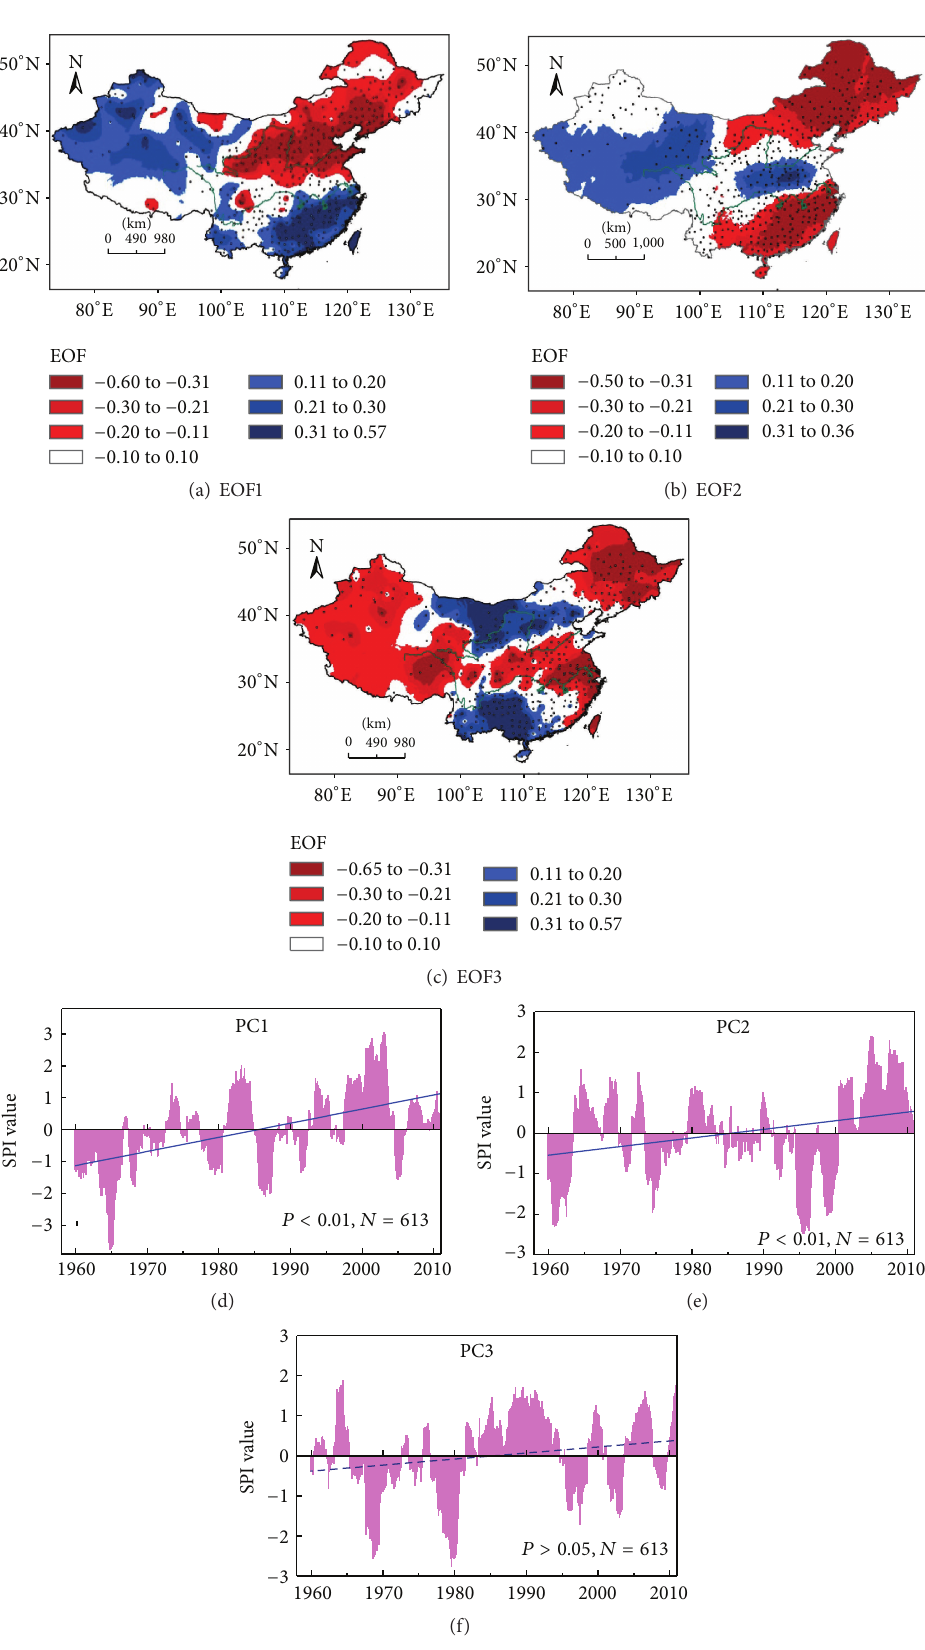
Figure 2: The first three EOF and PC of SPI-24 in China during the period of 1958–2010 (solid linear line in (d) and (e) means the significant linear trend at > 95% level and the dashed linear line in (f) means a nonsignificant linear